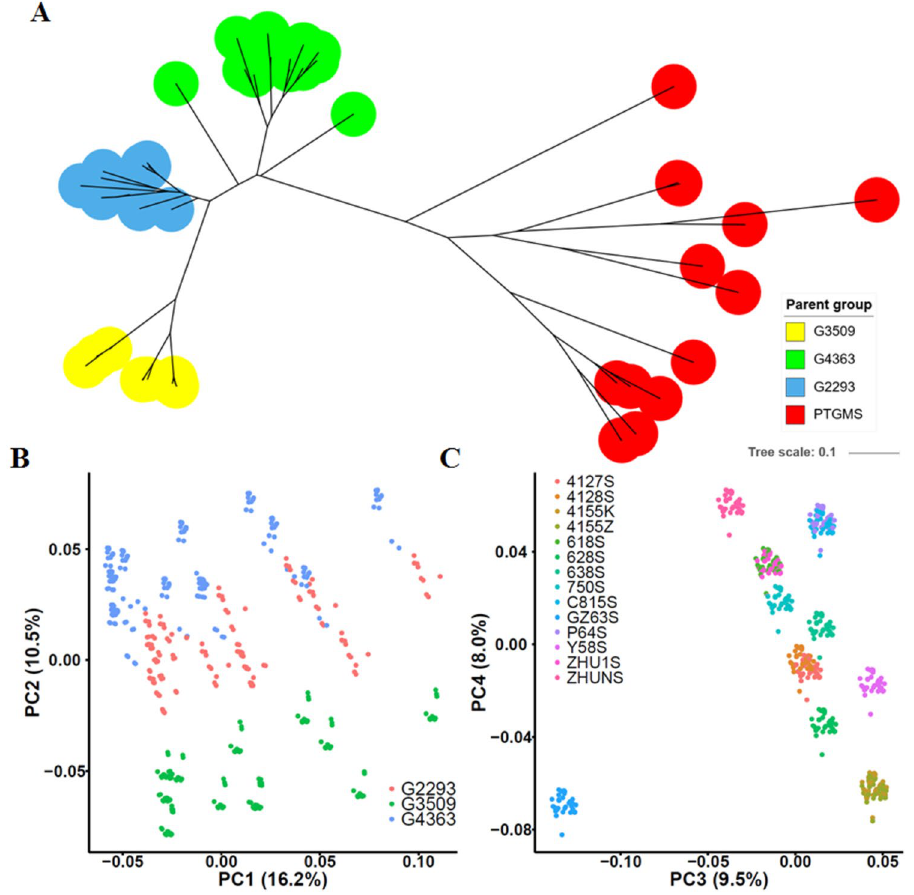
Figure 2. Phylogenetic relationships among parental lines ( A ) and population structure among F1 hybrids ( B,C ).